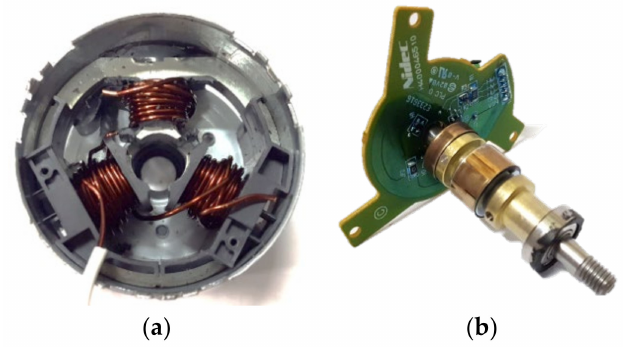
Figure 1. Photograph of reference motor specification: ( a ) stator and ( b )